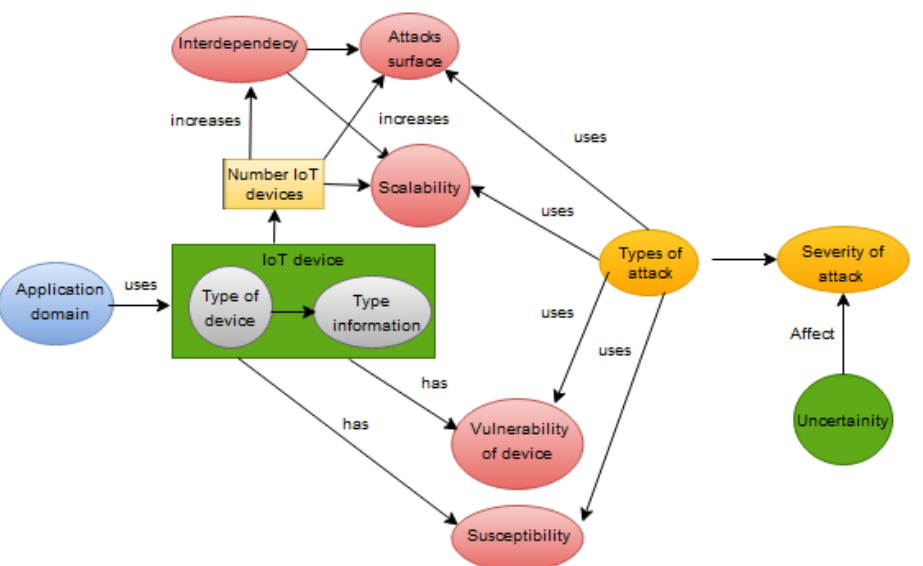
Figure 5. Initial reference model for risk analysis in IoT systems based on IoT device factors.